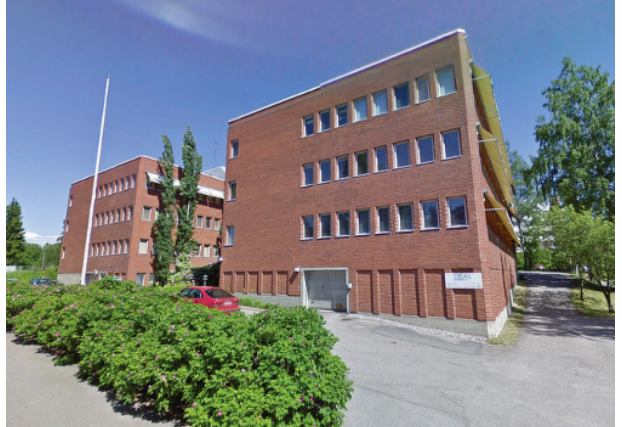
Figure 2. Four-story brick-clad office building to be demolished.